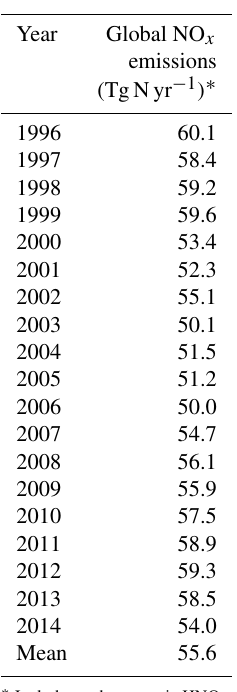
Table 1. Global top-down NO x emissions calculated using the finite mass-balance inversion approach with observations from GOME, SCIAMACHY, and GOME-2. Year Global NO x emissions